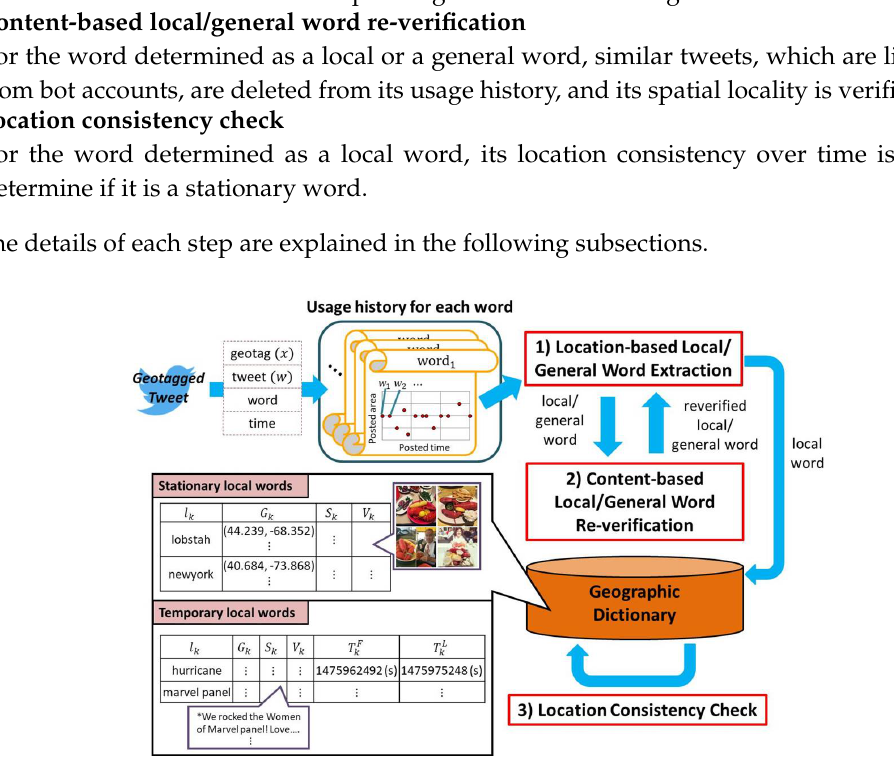
Figure 1. Overview of proposed